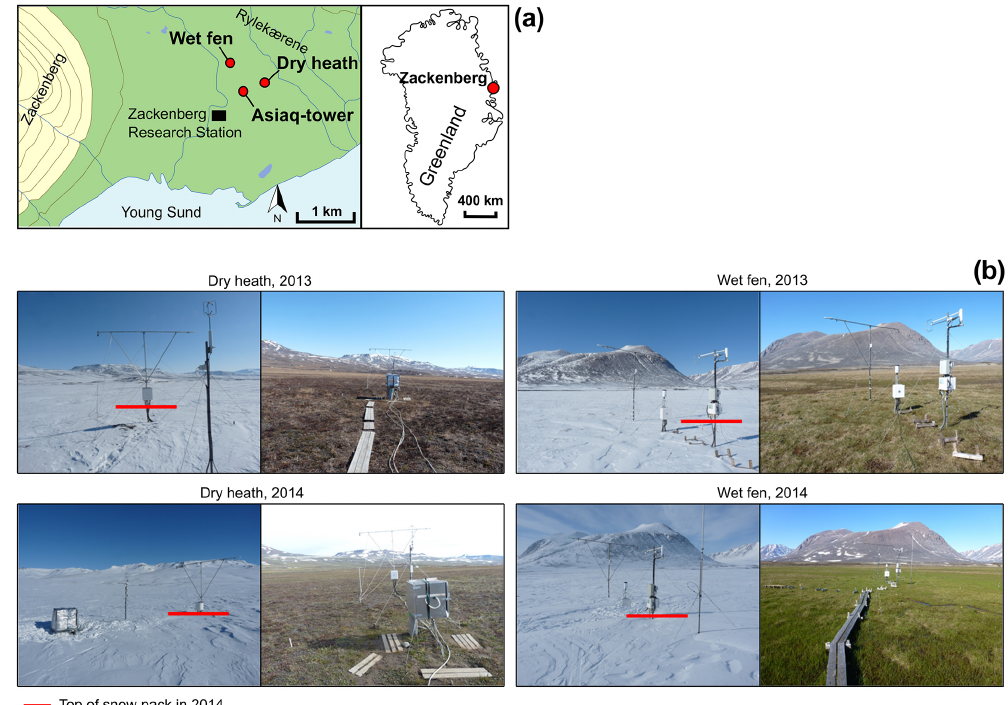
Figure 1. (a) Location of the study sites in Zackenberg, Northeast Greenland (base map provided by NunaGIS). (b) Characteristics of the study sites during the beginning of the snowmelt periods and during the growing seasons in 2013 and